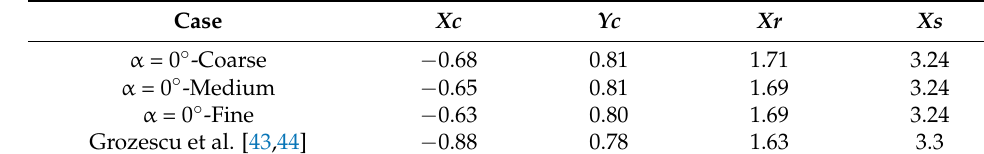
Table 3. Coordinate values of feature points of the recirculation bubble.